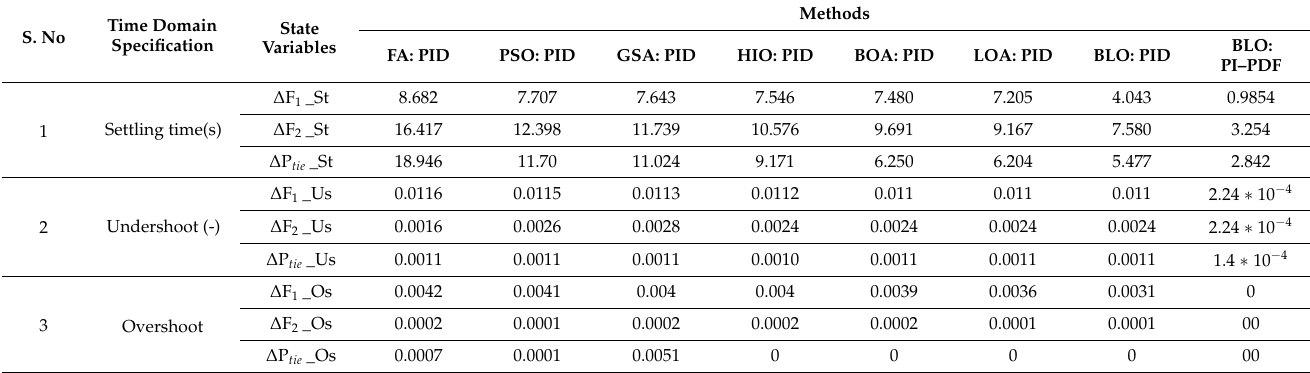
Table 3. Time domain analysis for scenario-I.